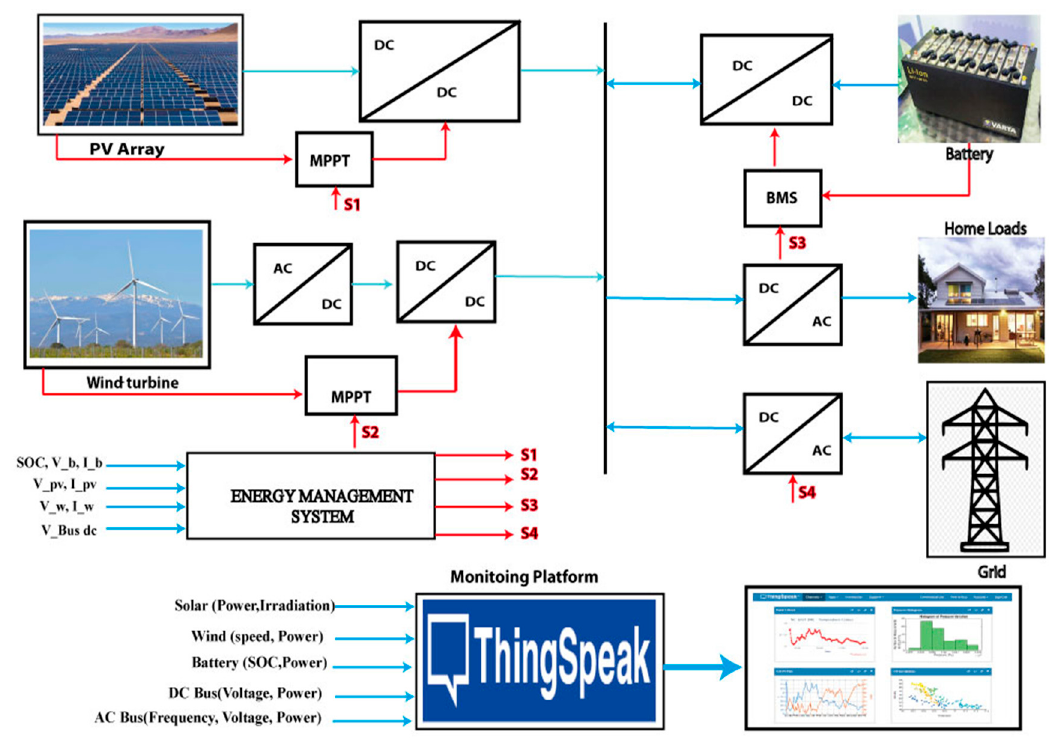
Figure 4. Proposed energy management and monitoring system for the microgrid.